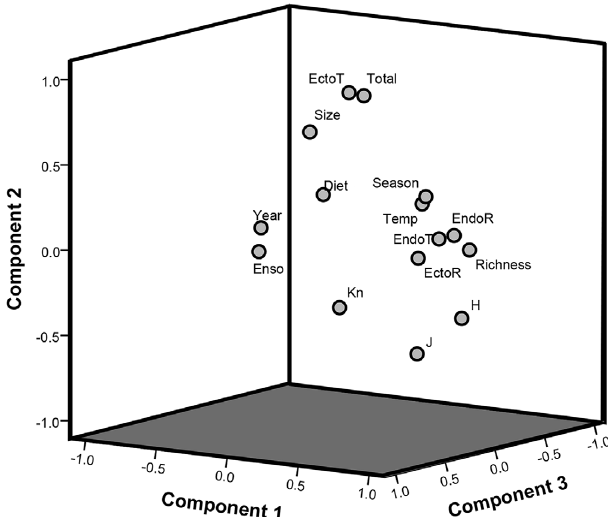
Figure 3. Scatter plot of the principal component analysis (PCA) of factors that in fl uence the species richness and diversity of the parasite infracommunities of Caranx sexfasciatus , from Acapulco Bay. Predictor variables: Year = sampling year, Season = climatic season (dry/rainy), Temp = surface temperature values, Enso = Multivariate El Niño index, Size = host body size (total length), K n = condition factor, Diet = host diet variety, EndoR = number of endoparasite species, EctoR = number of ectoparasite species, EndoT = total number of endoparasites per host, EctoT = total number of ectoparasites per host. Infracommunity parameters: Richness = number of parasite species per infracommunity, Diversity = Brillouin diversity index values, Load = total number of parasites per infracommunity, Evenness = species evenness.